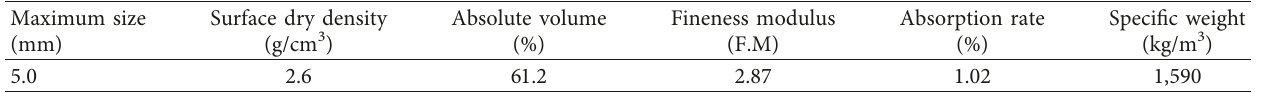
Table 2: Physical properties of fine aggregates.